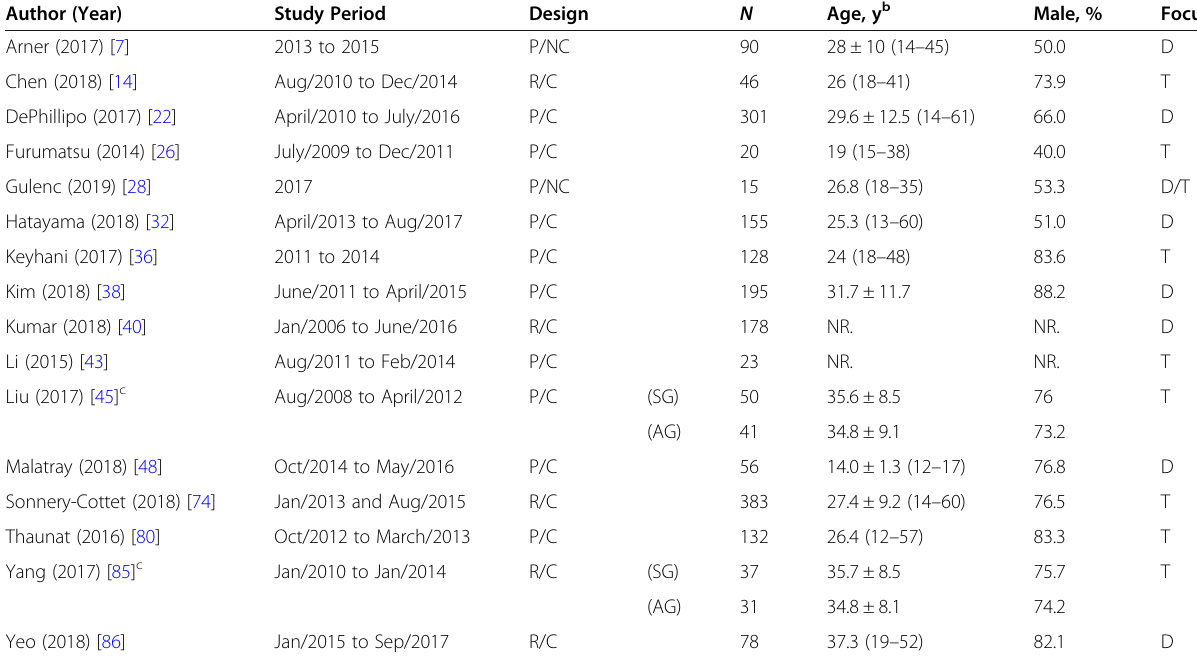
Table 1 Study and Patient Characteristics